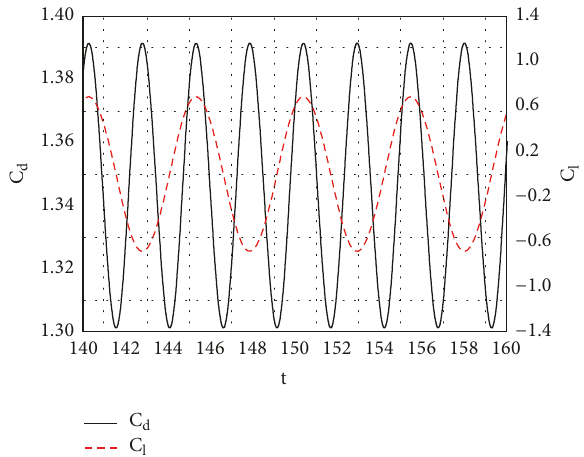
Figure 9: Temporal evolution curve of lift coefficients and drag coefficients.